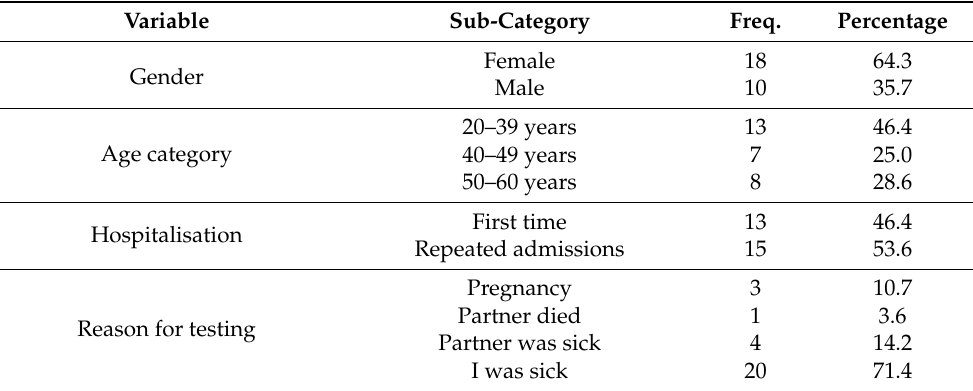
Table 1. Sociodemographic, clinical, and disclosure characteristics of the study